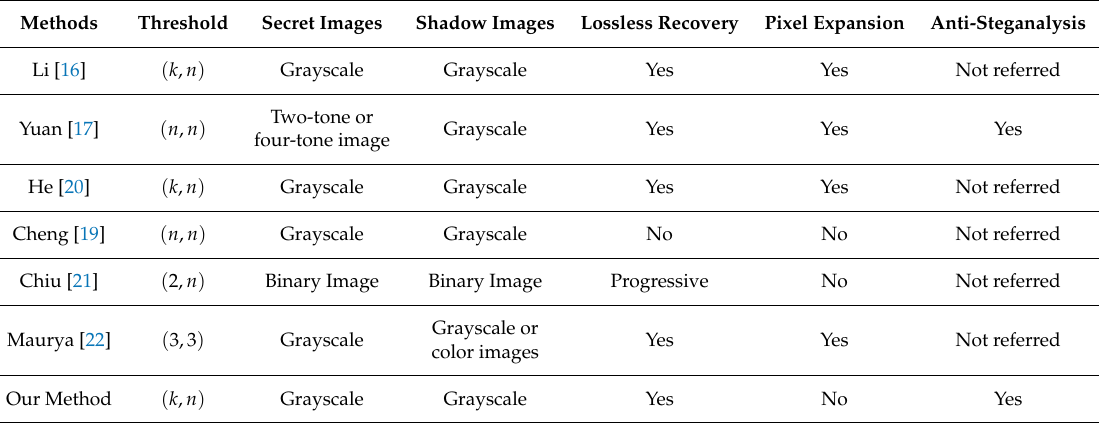
Table 8. The comparison on characteristics among different